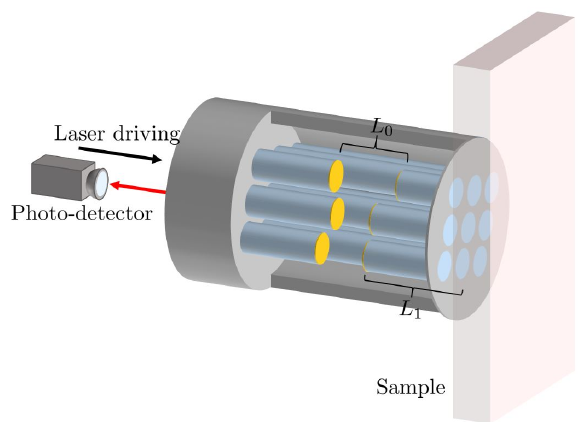
Figure 3. Alternative design of a remote sensor with increased selectivity, which allows for different resonant frequencies to be probed at once. The sensor contains a bundle of optical fibres encased in a protective sheath and embedded with cavities of different lengths L 0 . By measuring the resultant change for each resonance frequency from a known baseline, the type and concentration of the sample to be measured can be determined more easily.